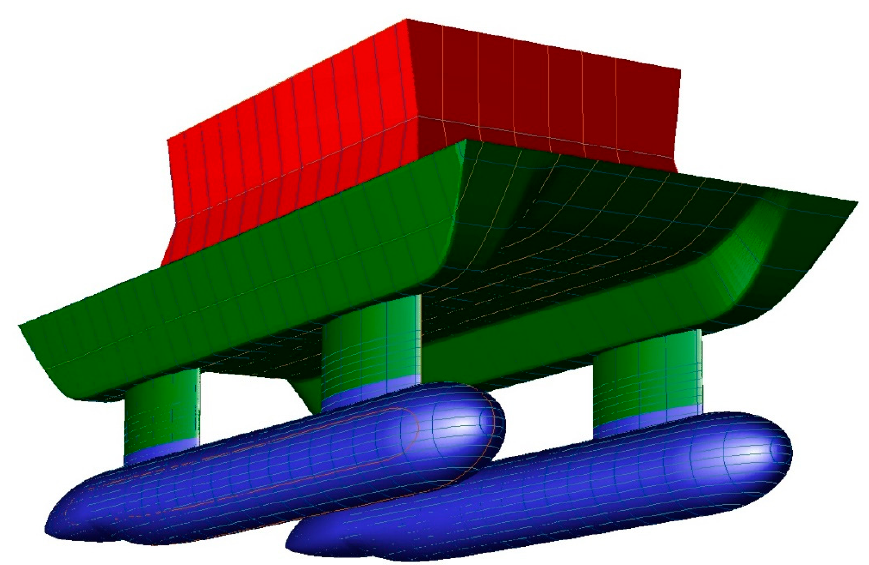
Figure 5. Geometric shape of the SWATH II hull in FREE!ship [61].